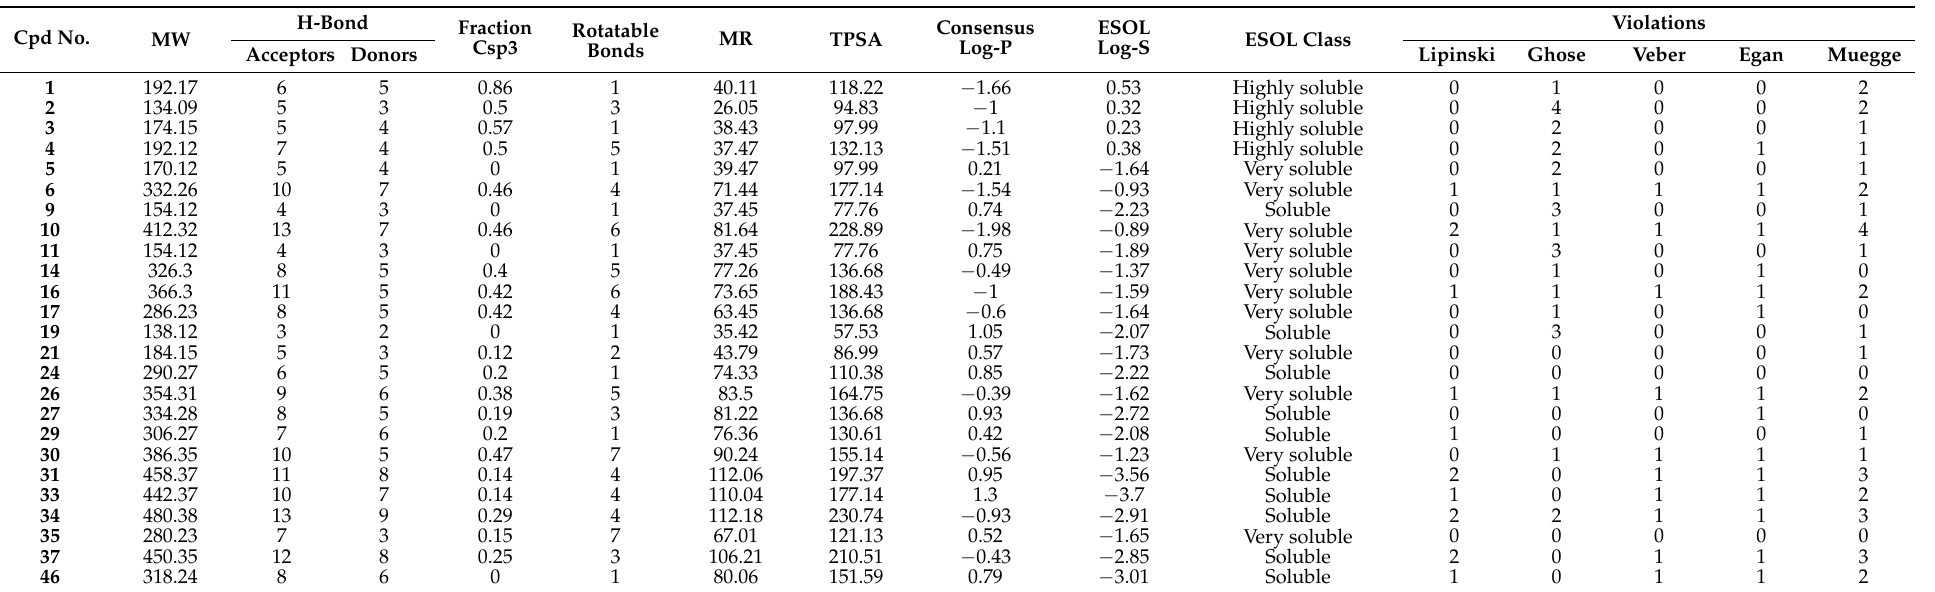
Table 6. Drug likeness results of the identified compounds from E. divinorum